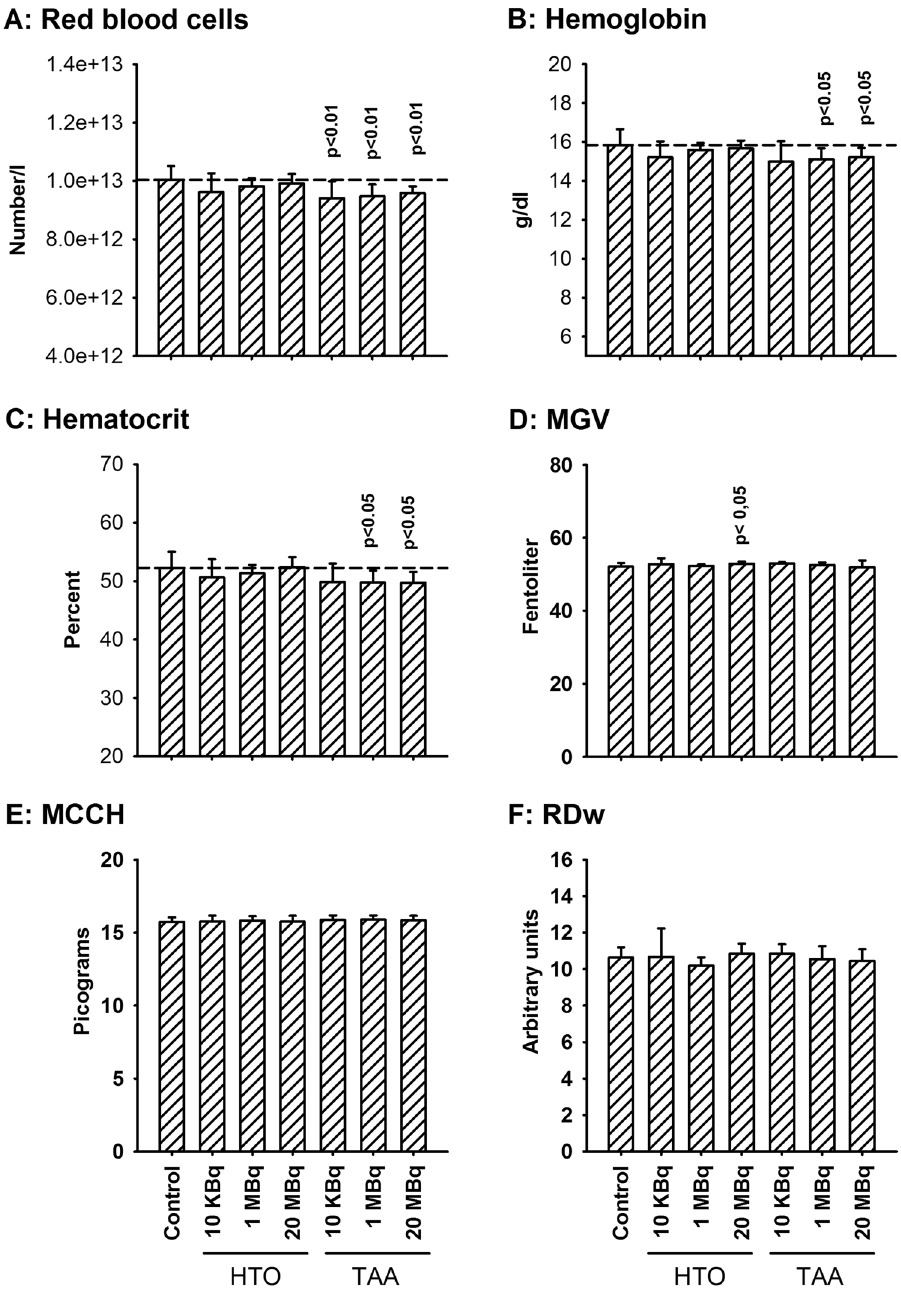
Figure 2. Red blood cell parameters in animals after one month of exposure to either HTO or TAA. ( A ) Red blood cell counts; ( B ) hemoglobin; ( C ) hematocrit; ( D) mean globular volume (MGV); ( E ) mean corpuscular content in hemoglobin (MCCH); ( F ) RBC distribution index (RDw). Results are mean ± SD, n = 11. Using a one-way ANOVA test significant differences were observed for RBC counts (H (6) = 15.2, p = 0.005), hemoglobin (H (6) = 15.2, p = 0.018), hematocrit (H (6) = 15.4, p = 0.018) and MGV (H (6) = 16.5, p = 0.011) but not for MCCH. Where present, the horizontal dashed line represents the mean value for the control group. The results indicate the appearance of an anemia after one-month’s exposure to TAA but not to